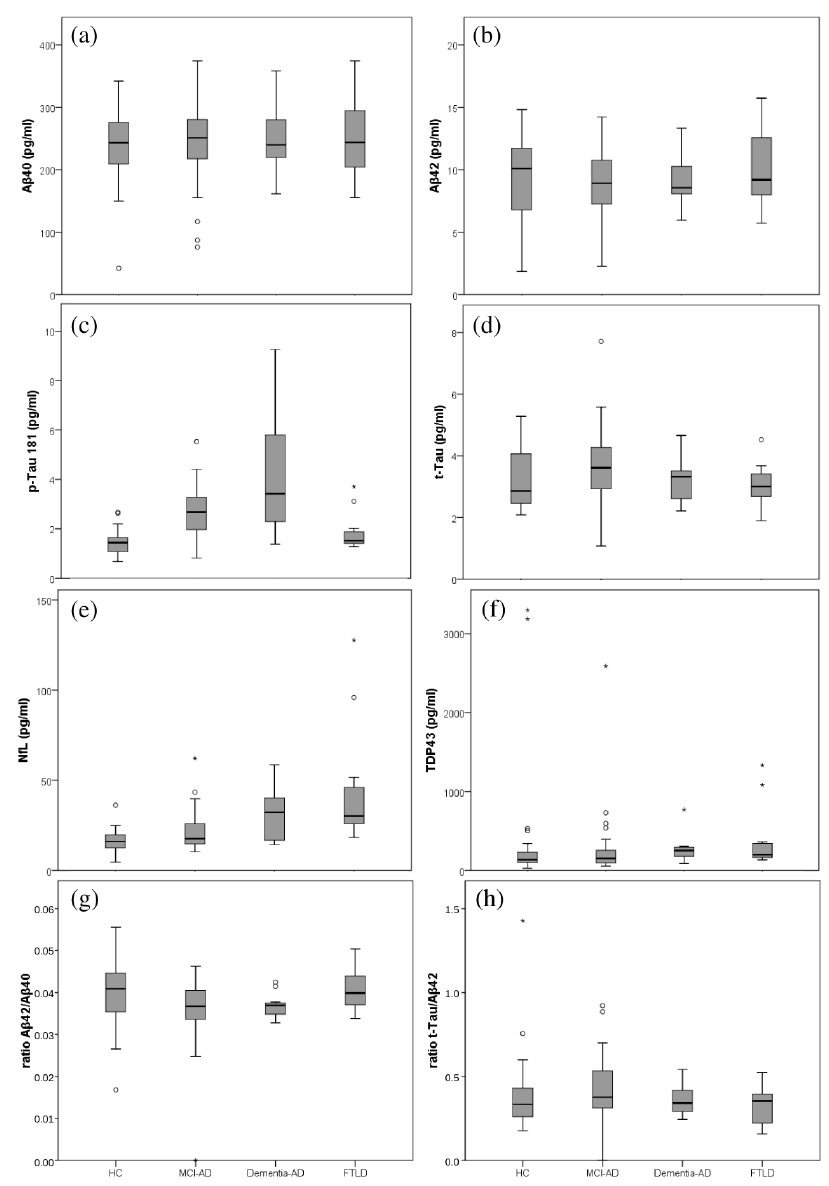
Figure 1. Box plots representing the plasma levels in the different participants groups (healthy controls (HC), MCI-AD, dementia-AD, FTLD). ( a ) A β 40; ( b ) A β 42; ( c ) p-Tau181; ( d ) t-Tau; ( e )